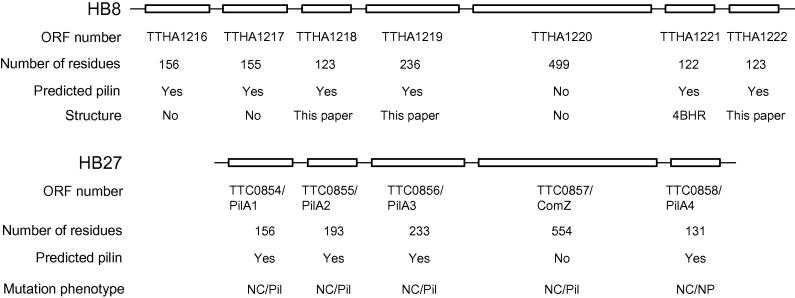
Type IV pilin clusters in T. thermophilus HB8 and HB27. Number of residues indicated are before predicted processing by PilFind (Imam et al., 2011). ORF names for the HB27 pilins are those given by Friedrich et al. (Friedrich et al., 2003). For the mutation phenotypes, NC is non-competent, Pil is piliated and NP is non-piliated.